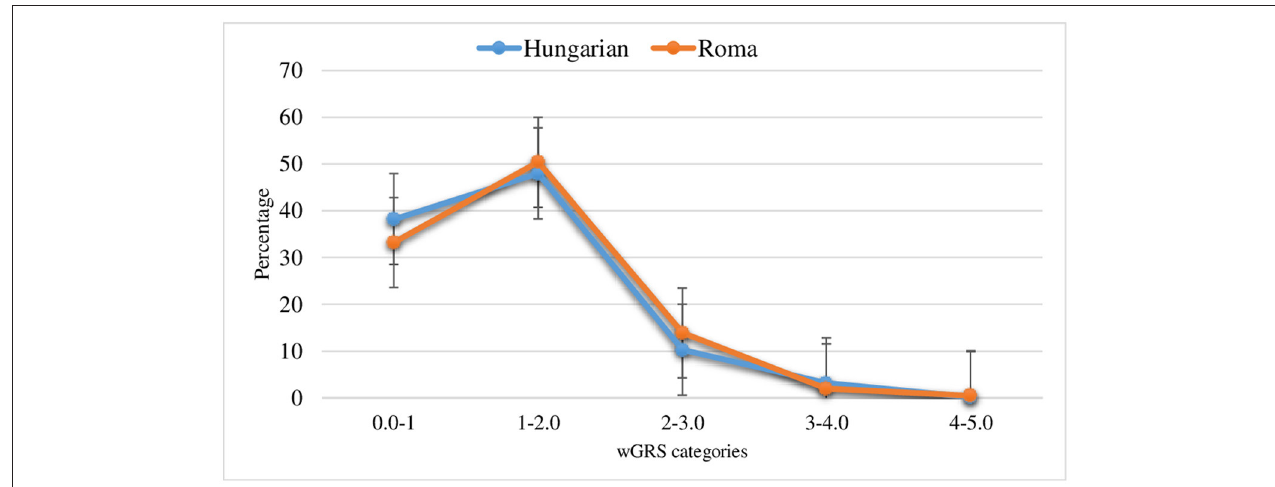
FIGURE 1 | Distribution of wGRS in the general Hungarian and Roma population (The error bars indicate the standard error of the mean).